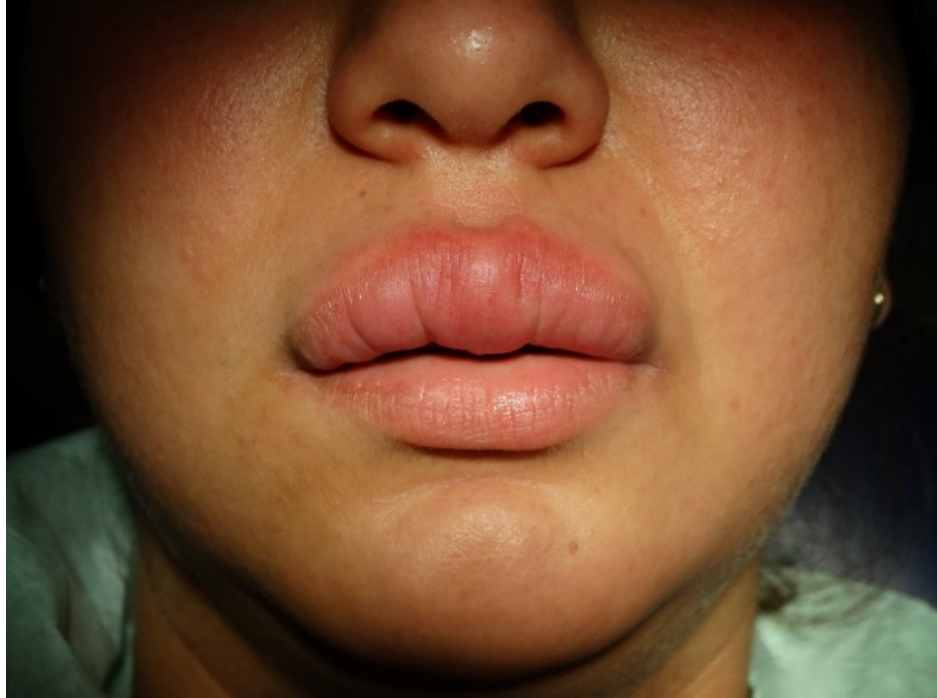
Figure 1. A pretreatment view of the upper lip shows diffuse erythematous swelling tender on palpation. The lip contour is blurred.